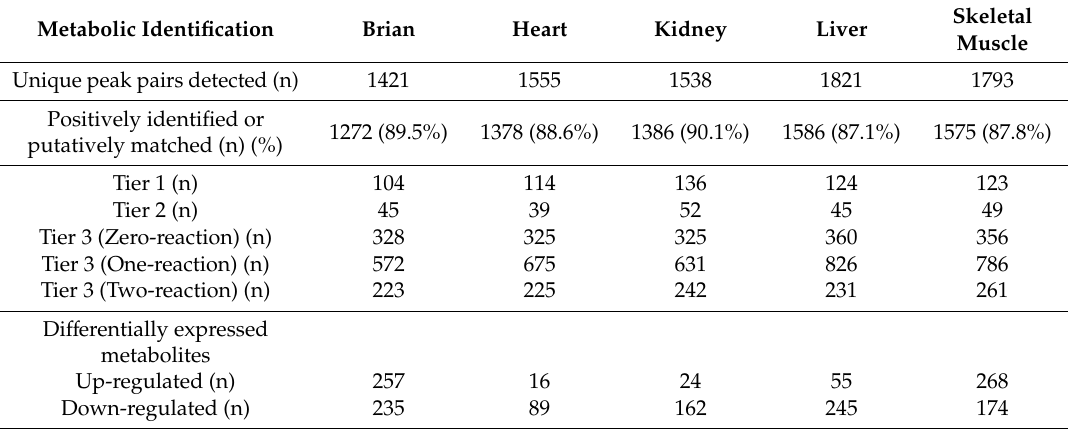
Table 1. Summary of the identified peaks and the differentially expressed metabolites in the five morphologically altered tissues after prolonged dexamethasone (Dex) administration.